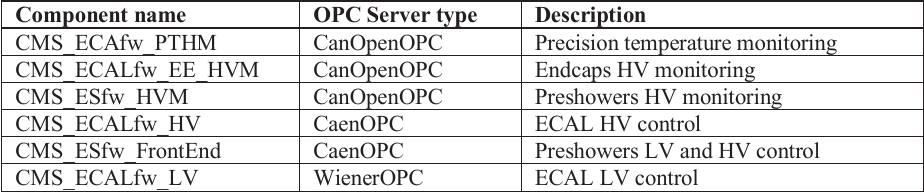
Table 2. List of CMS ECAL DCS components affected by the migration of different OPC